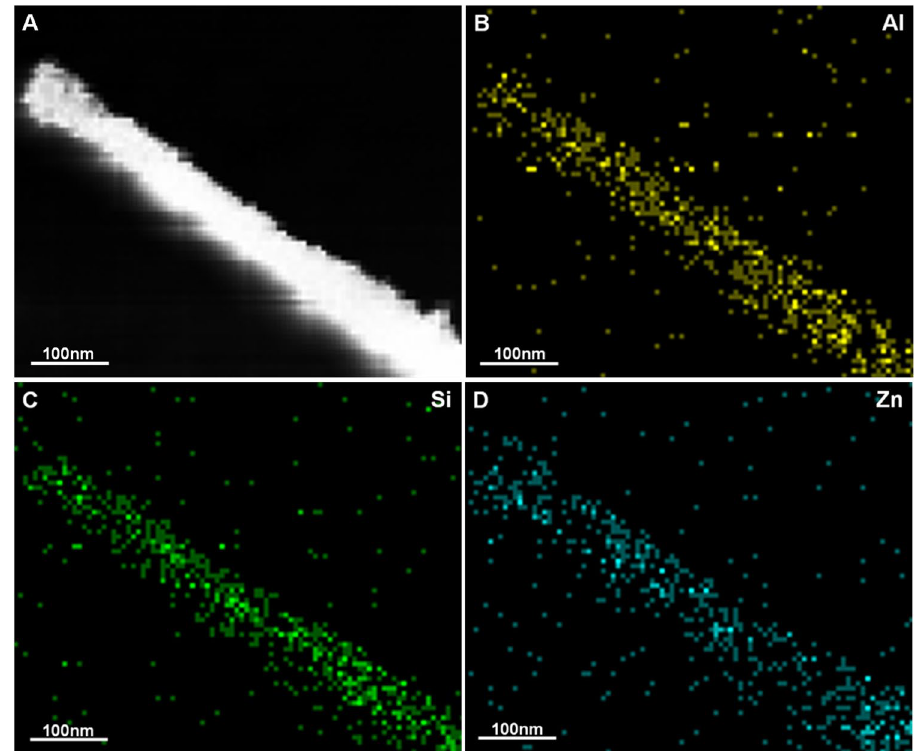
Figure 5. ( A ) TEM images of HNTs@ZnO nanocomposites; ( B – D ) energy dispersive X-ray (EDX) mapping of HNTs@ZnO nanocomposites.